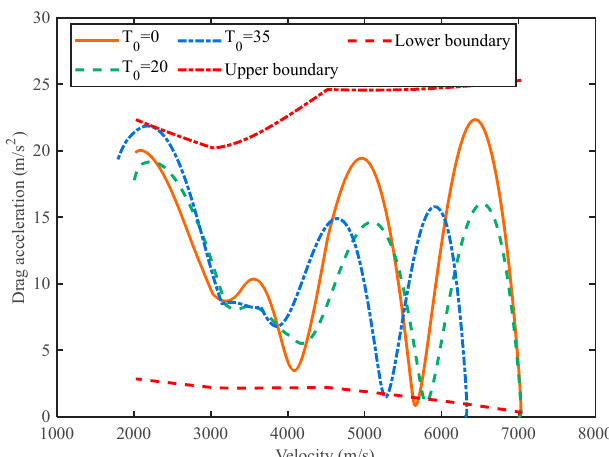
Figure 10. Time histories of the velocity.